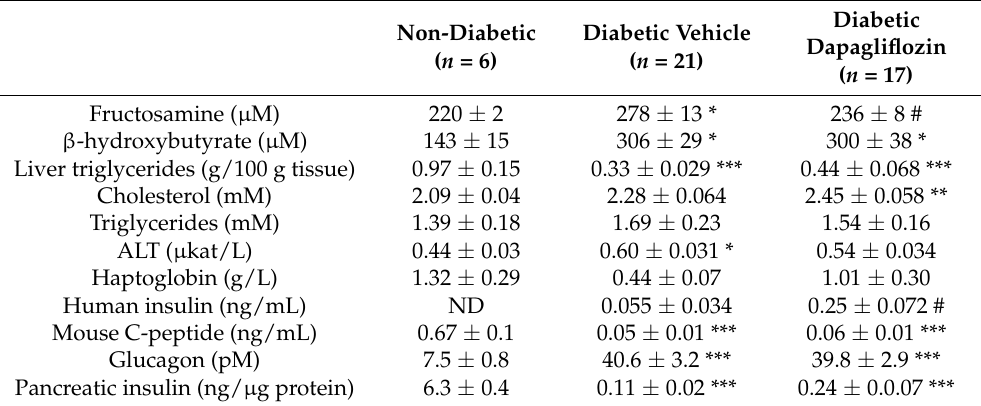
Table 1. Plasma biochemistry, liver triglyceride, and pancreas insulin content in mice from normo- glycemic sham-operated mice, diabetic vehicle mice, and dapagliflozin-treated diabetic mice at the termination of the